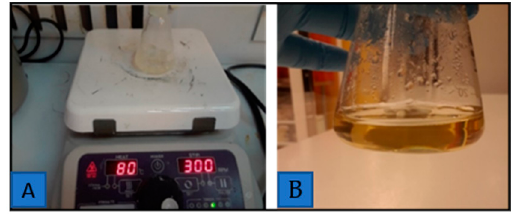
Figure 1. ( A ) Stirrer and heater and ( B ) yellowish solution.